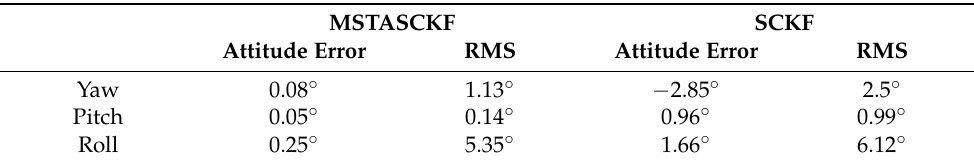
Table 3. The attitude error and RMSE comparison between MSTASCKF and SCKF.